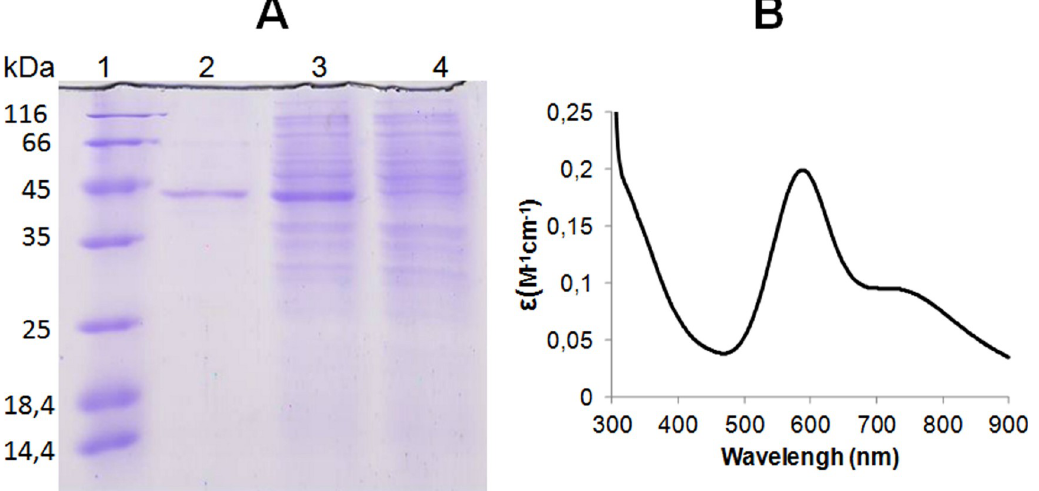
Fig 1. SDS-PAGE (A) and absorption spectra of SpSL (B). (A): 1, molecular weight markers; 2, SpSL preparation after a HisTrapp 5-ml column; 3, E . coli culture with IPTG; 4, E . coli culture without